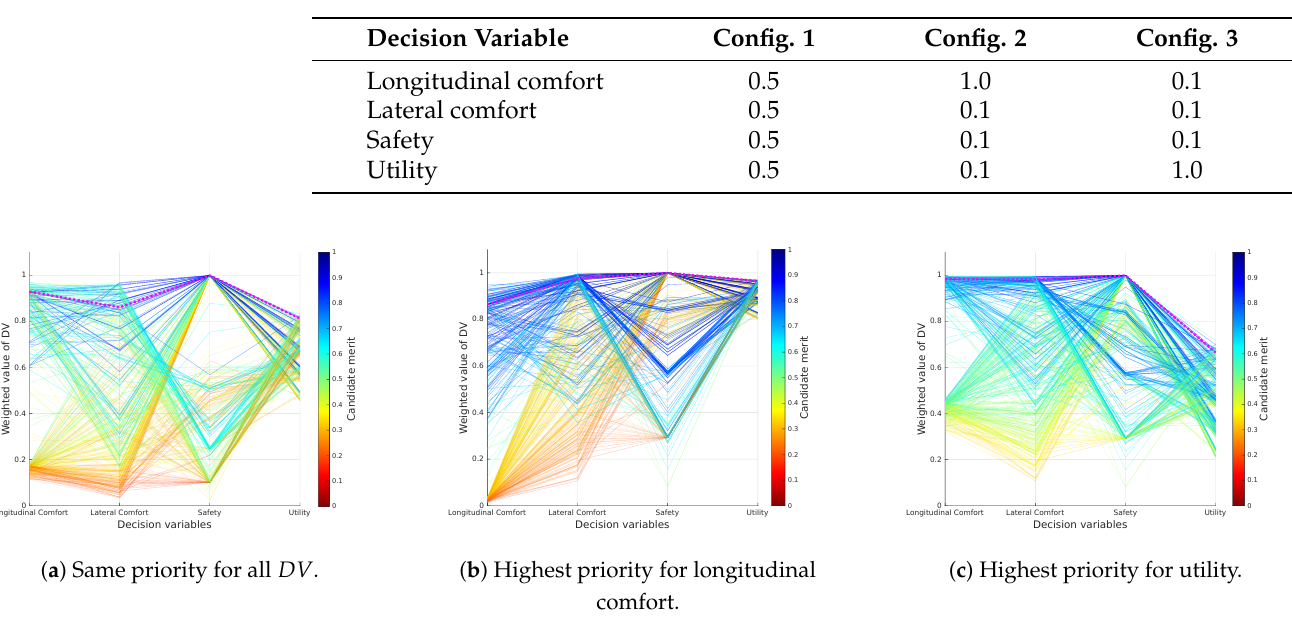
Figure 11. Reachability maps of the trajectory set ( Γ ) when different weight configurations are applied to DV